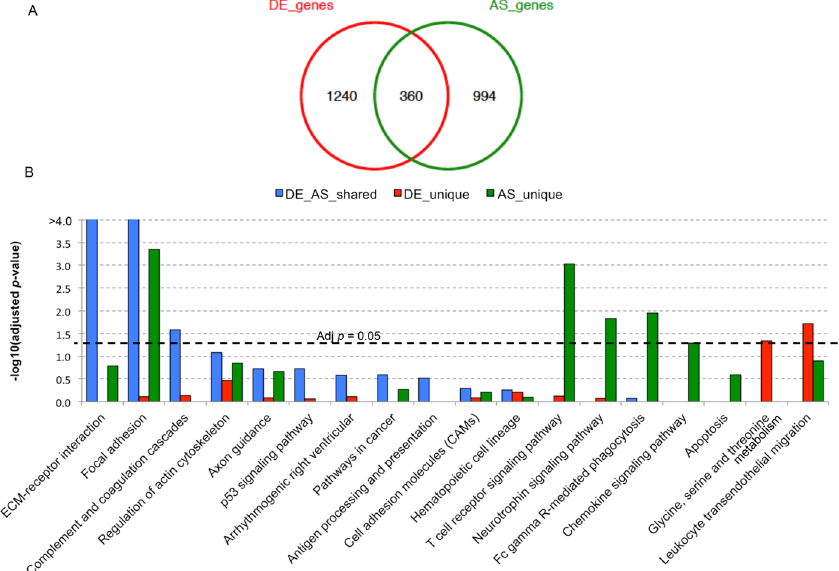
Figure 4. Comparison between DE and AS genes. ( A ) The overlapping patterns between differentially expressed (DE) genes and alternatively spliced (AS) genes. ( B ) The KEGG pathway enrichment for unique DE genes (red), unique AS genes (green) and genes with both DE and AS signatures (blue). The –log 10 (adjusted p - values) is shown at the